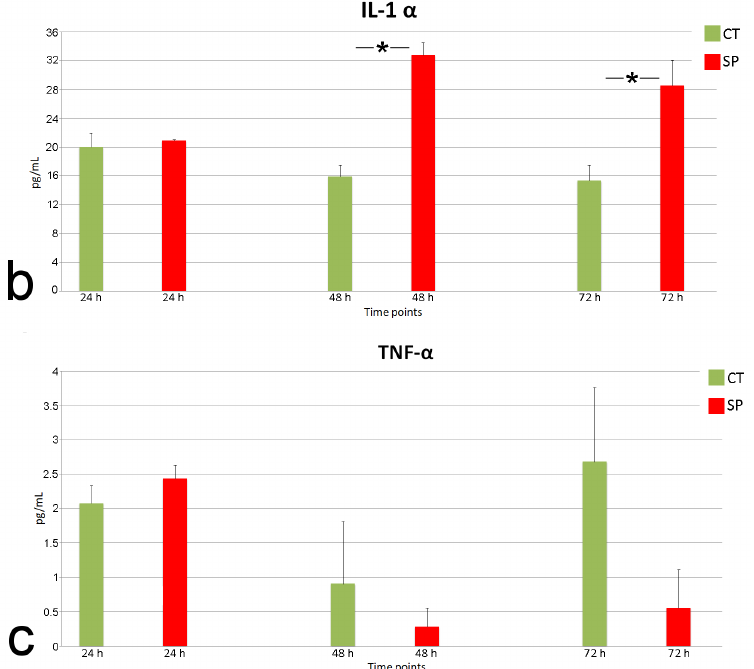
Figure 16. ( a ) Mean ± standard error values of IL-6 in culture medium of samples treated with substance P. Asterisks indicate significant difference (24 h CT vs. 24 h SP, p = 0.048; 48 h CT vs. 48 h SP, p = 0.040). ( b ) Mean ± standard error values of IL-1 alpha in culture medium of samples treated with substance P. Asterisks indicate significant difference (48 h CT vs. 48 h SP, p = 0.031; 72 h CT vs. 72 h SP, p = 0.042). ( c ) Mean ± standard error values of TNF-alpha in culture medium of samples treated with substance P. No significant difference was found. CT, control (untreated); SP, substance P